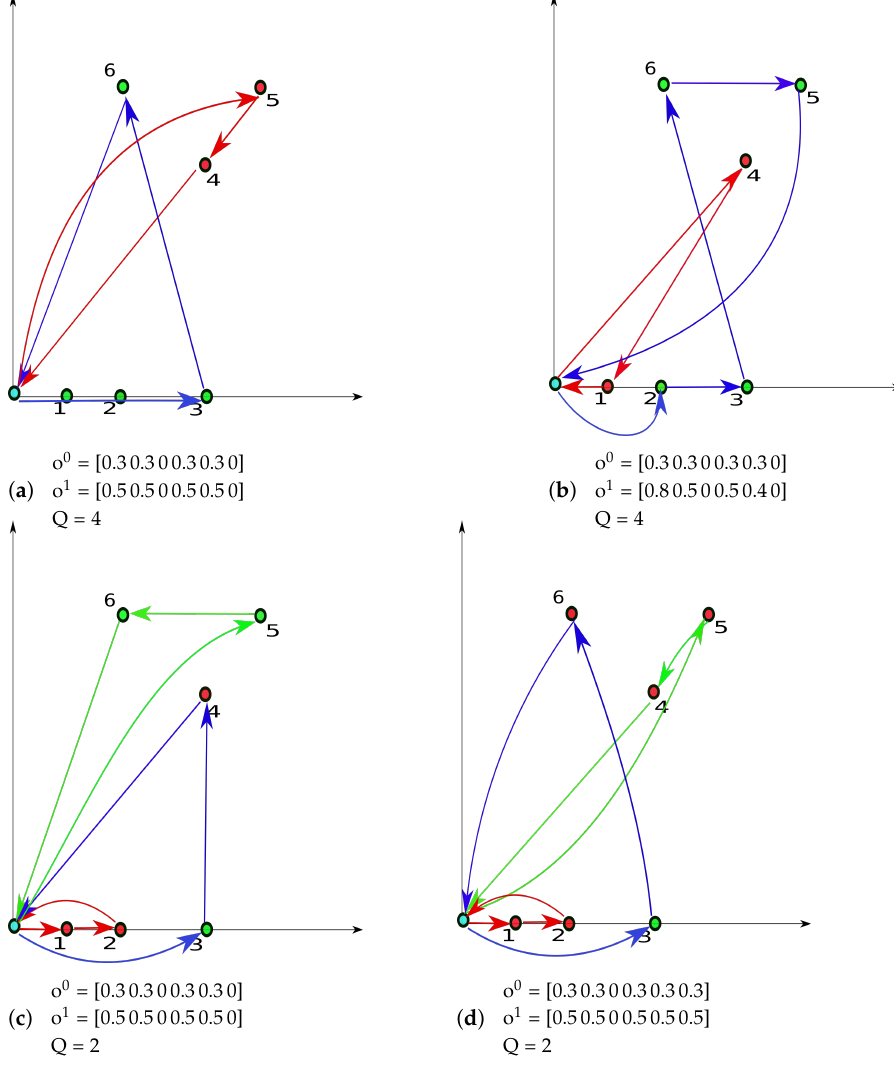
Figure 3. Initial Insights: ( a ) Instance a and optimal 2 routes; ( b ) Instance b and optimal 2 routes; ( c ) Instance c and optimal 3 routes; ( d ) Instance a and optimal 3